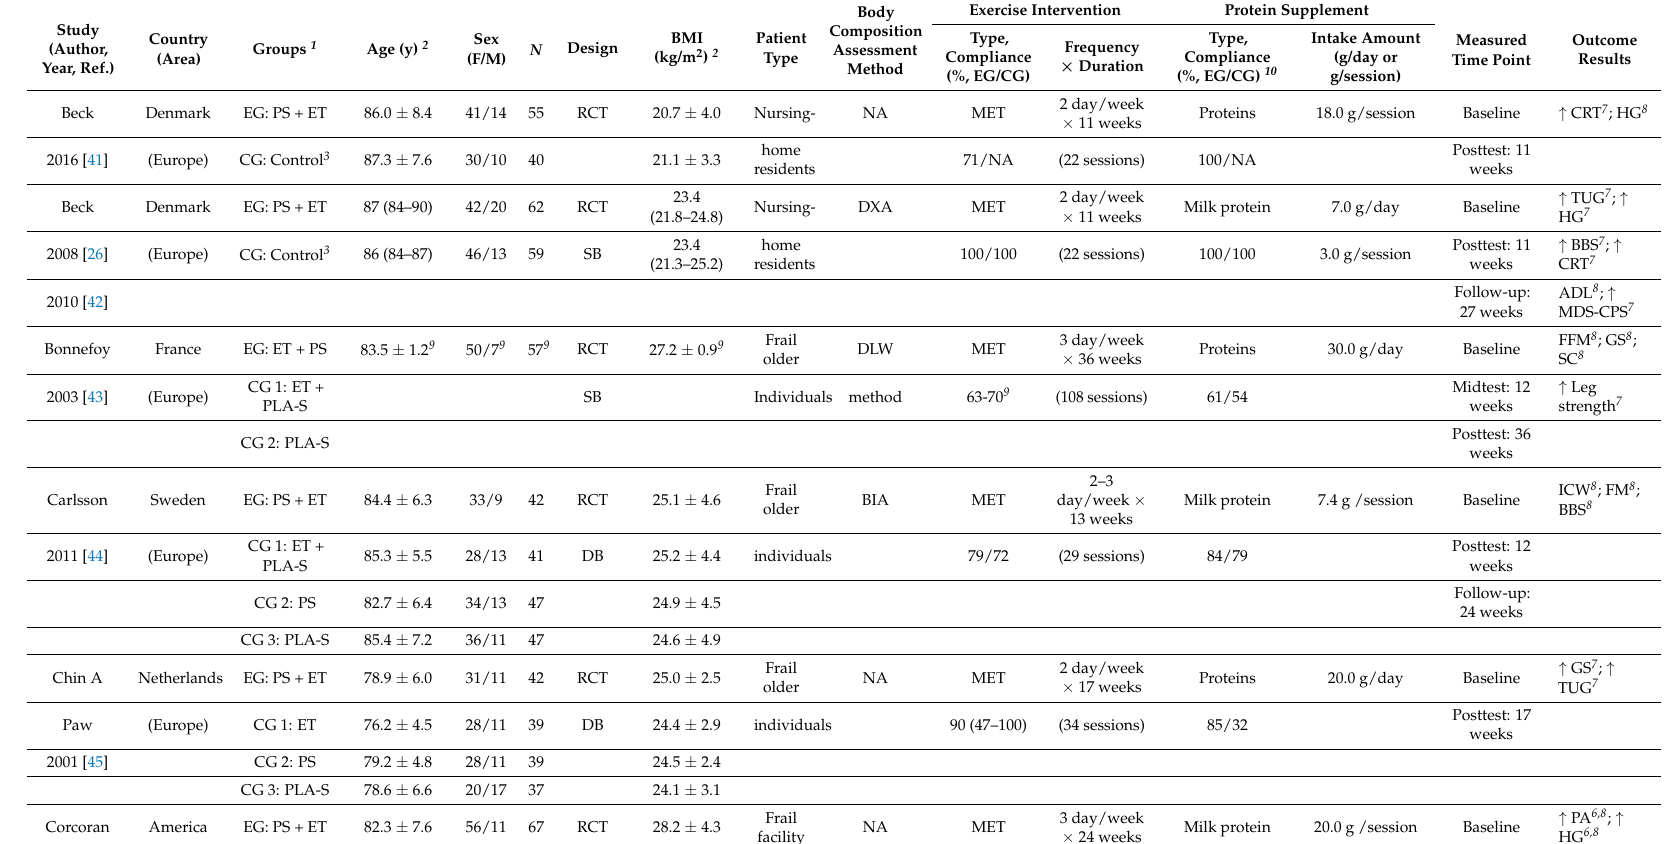
Table 1. Summary of study characteristics of included